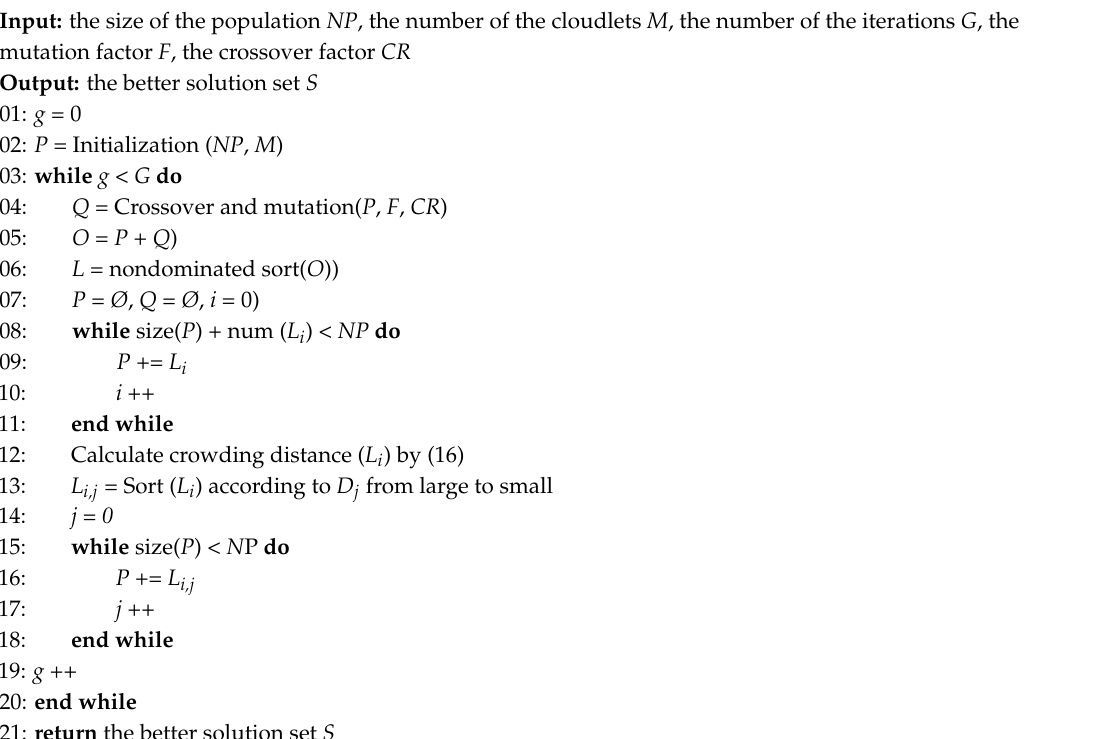
Algorithm 1. nondominated sorting differential evolution based offloading strategy acquisition.